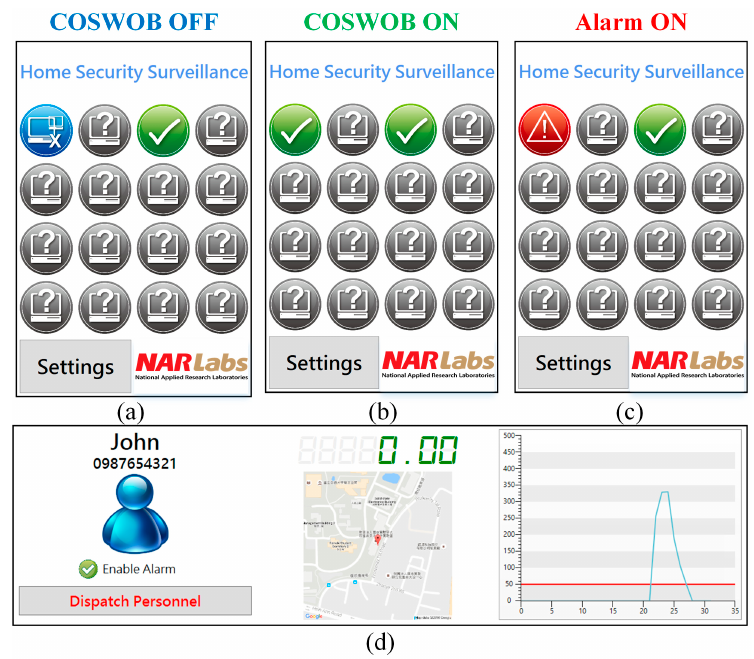
Figure 10. Screenshots of the main pages of the application run in the intelligent gateway, various states: ( a ) COSWOB OFF; ( b ) COSWOB ON; and ( c ) alarm activated; ( d ) Screenshot of the information of the COSWOB.